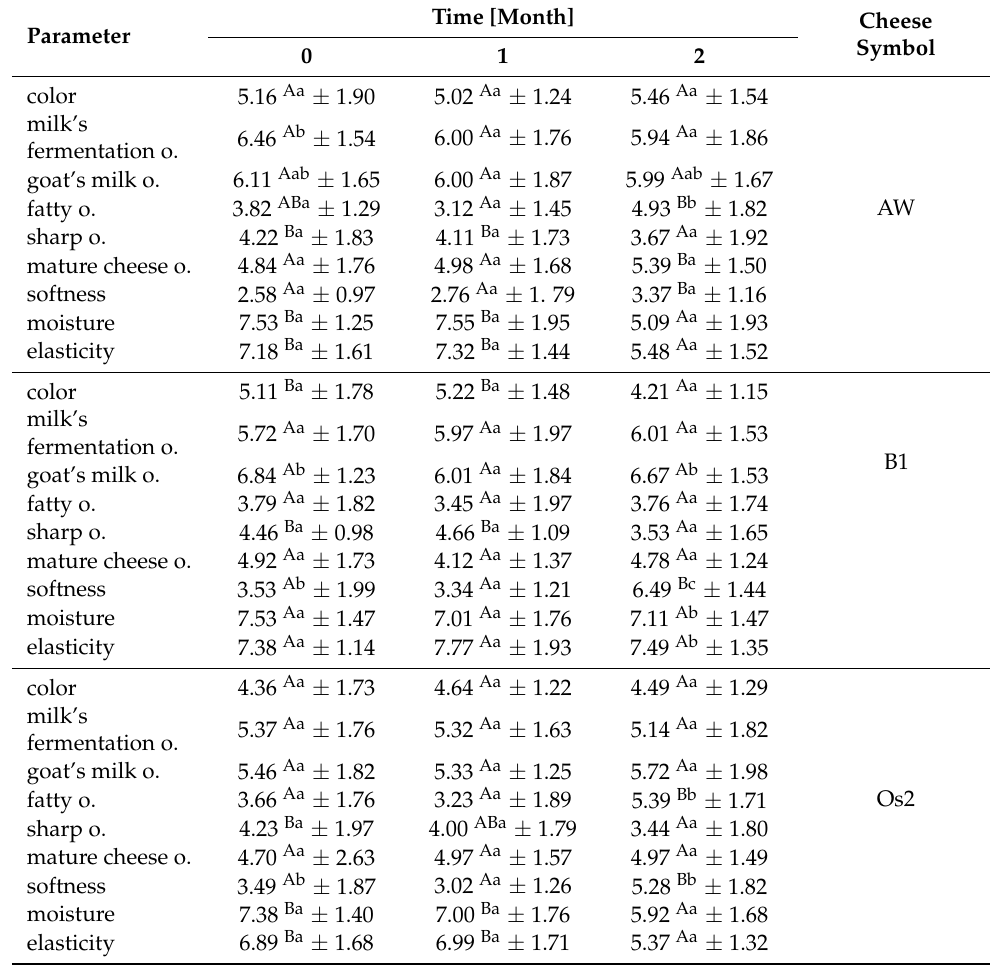
Table 5. Results of sensory evaluation of goat’s acid-rennet cheeses after production and after 1 and 2 months of